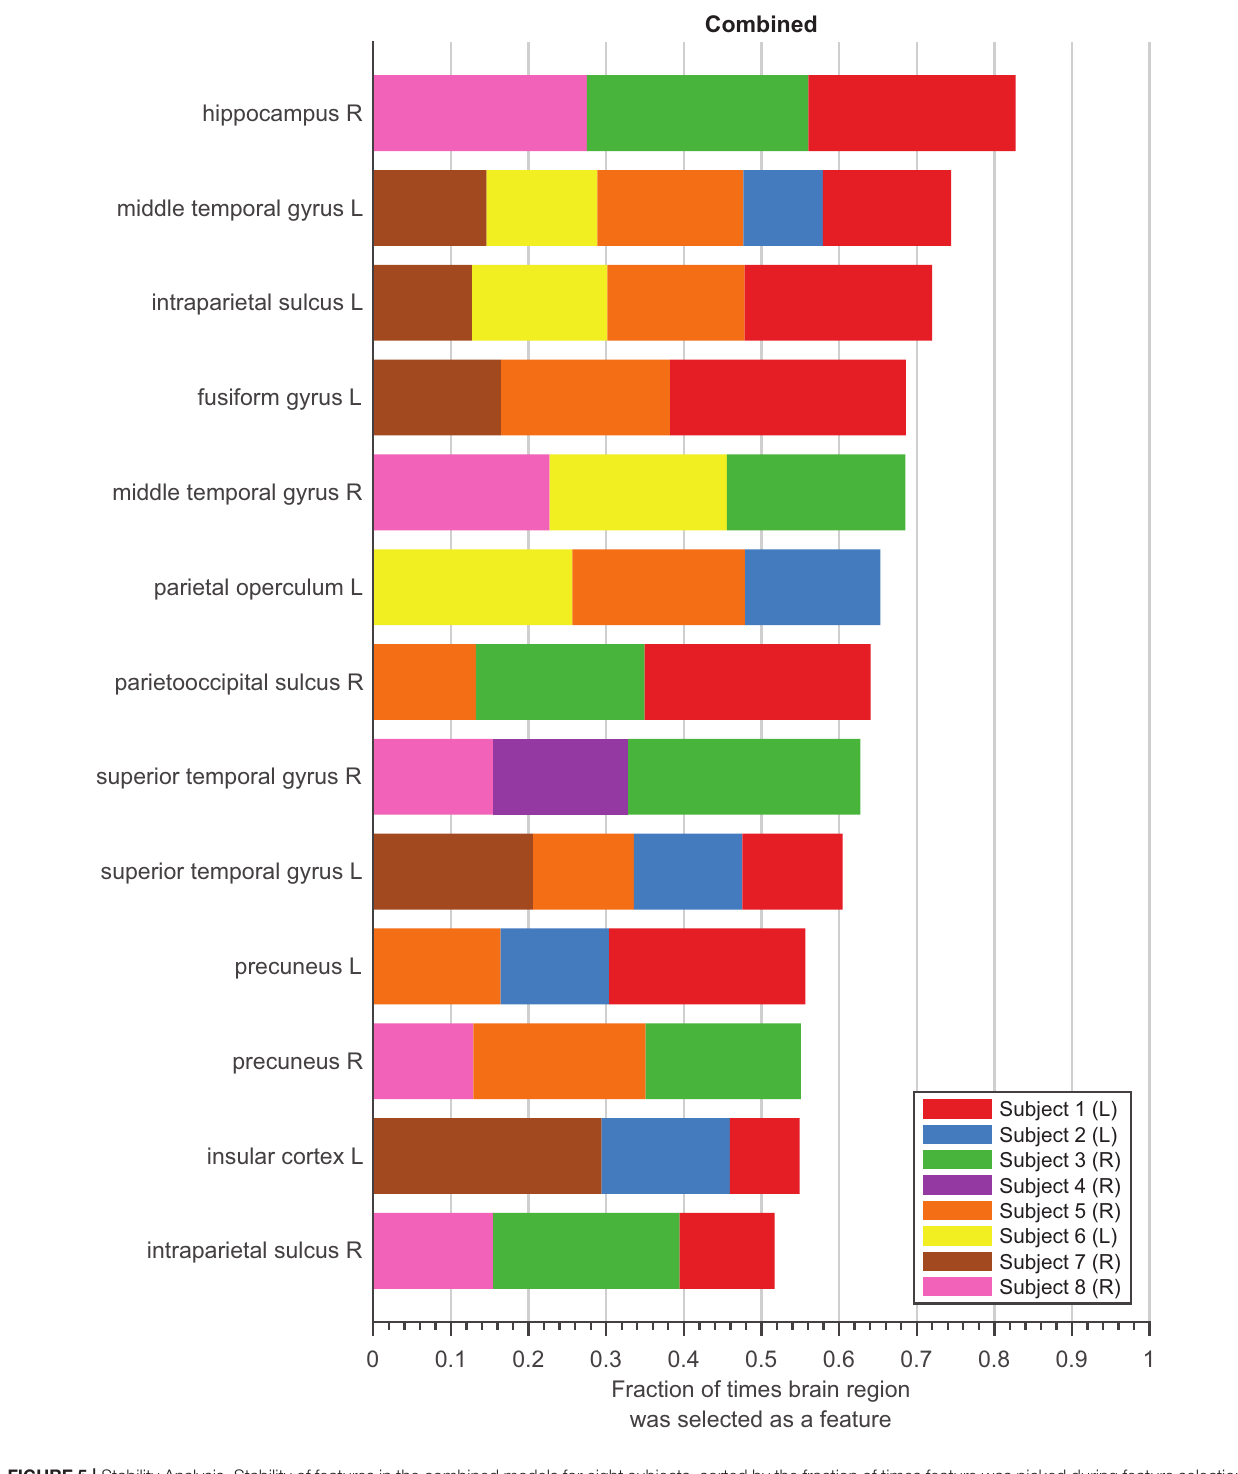
Frontiers in Neuroscience |